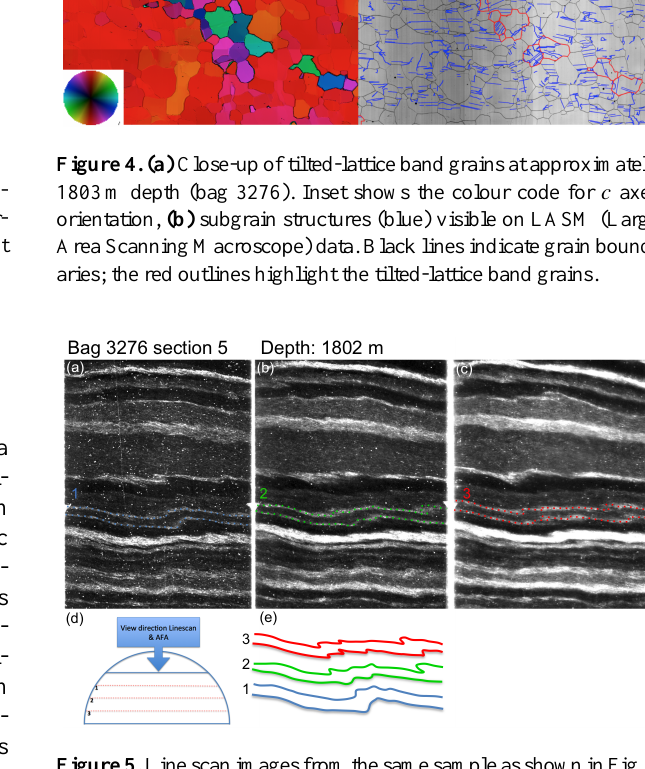
Figure 5. Line scan images from the same sample as shown in Fig. 3 from three focal depths with one highlighted layer (a) close to the surface, (b) in the centre of the core section, (c) close to the lower surface. (d) Sketch of the core sections; the upper part represents the physical properties sample, from which the thin sections are pre- pared. (e) Change of shape of the highlighted layer for the different